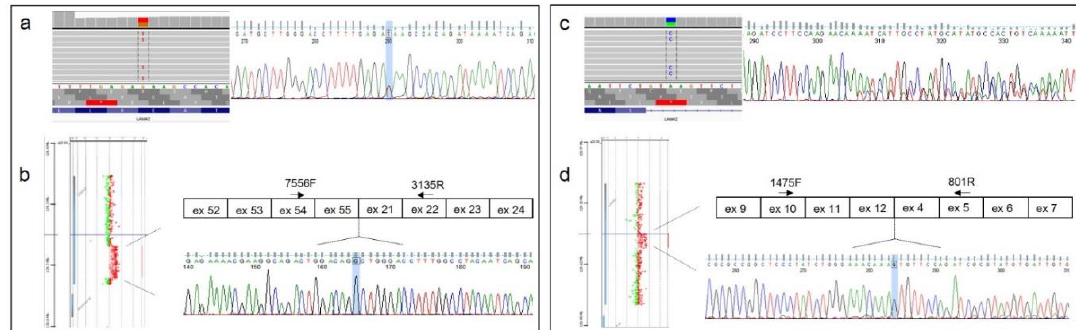
Figure 2. Molecular characterization of LAMA2 variants in patients V and VIII. Single nucleotide variants in LAMA2 occurred in compound heterozygosity with a duplication. ( a ) Integrative Genomics Viewer (IGV) [27] visualization and Sanger confirmation of c.5374G>T (patient V); ( b ) Characterization of exon 21–55 duplication on RNA (patient V). ( c ) The splice variant c.6429+3A>C characterized on muscle transcript, leads to skipping of exons 44–45 (patient VIII); ( d ) Fine mapping of the tandem duplication on muscle RNA transcript (patient VIII).